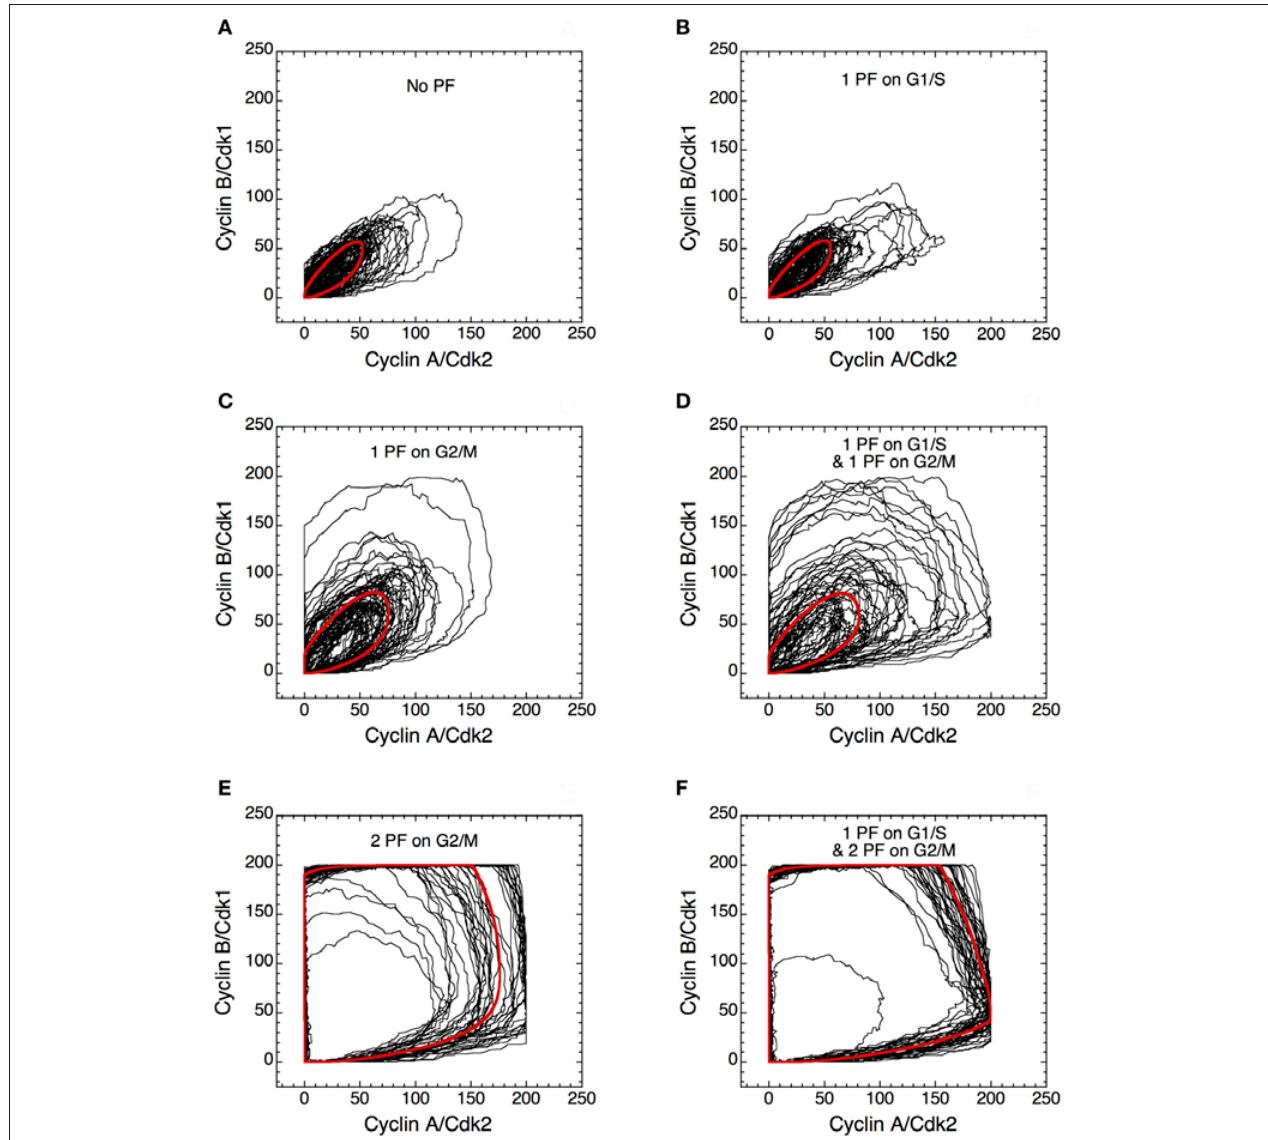
PF on G2/M via Cdc25 ( b 1 = 0, b 2 = 1, K ib = 1000 μ M), (D) one PF on G1/S and one PF on G2/M via Cdc25 ( b 1 = 1, b 2 = 1, K ib = 1000 μ M), (E) two PF on G2/M via Cdc25 and Wee1 ( b 1 = 0, b 2 = 1, K ib = 0 . 5 μ M), and (F) one PF on G1/S and two PF on G2/M ( b 1 = 1, b 2 = 1, K ib = 0 . 5 μ M). All simulations were performed in the presence of strong ultrasensitivity ( K = 0 . 005 μ M). Parameter values are as in Tables 2 and 3 in Gérard et al. (2012), with V 1e2f = 0 . 35h − 1 , V 1Me = 1 μ M − 1 h − 1